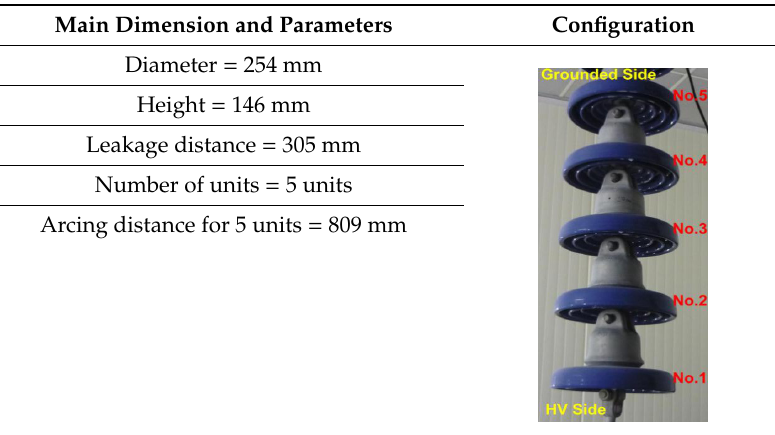
Table 1. Configuration, dimensions, and parameters of each unit of the test specimen.